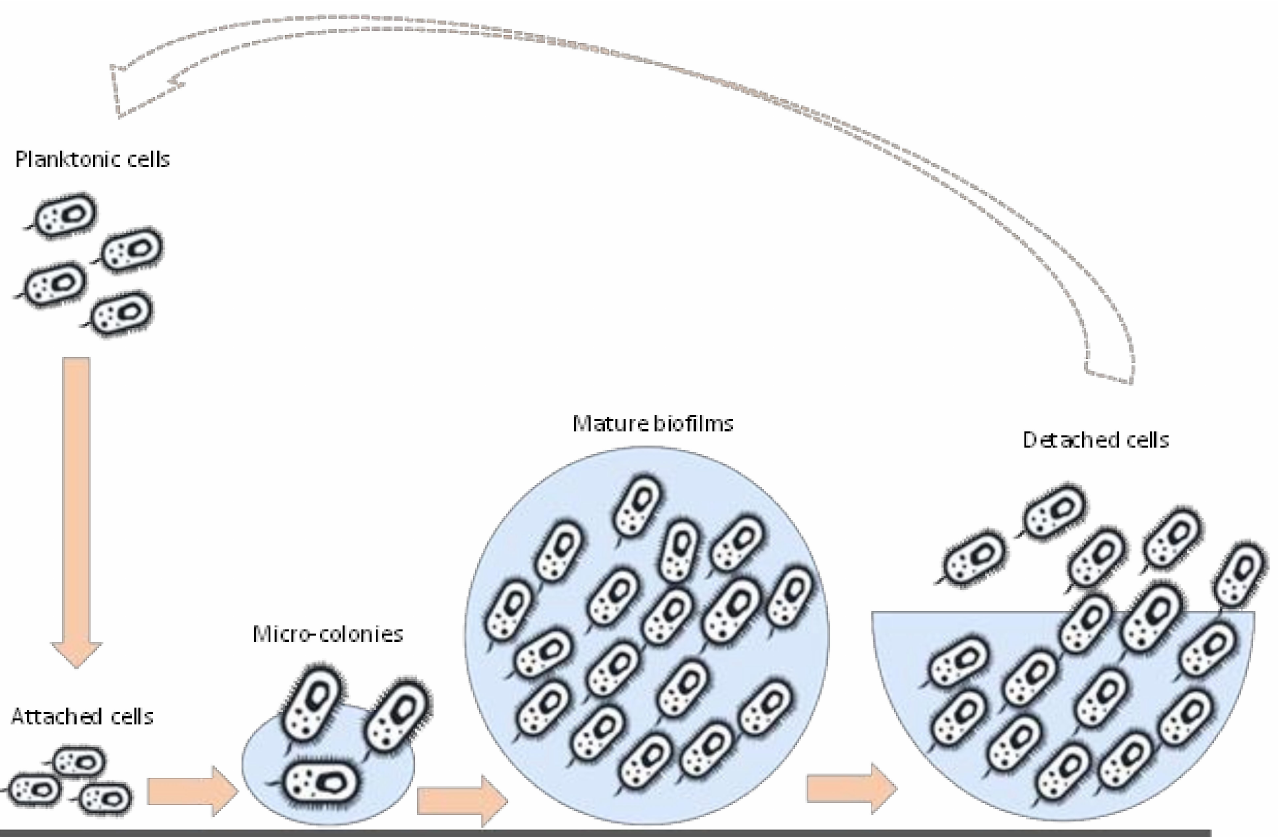
Figure 1. A schematic diagram showing the life cycle of microbial